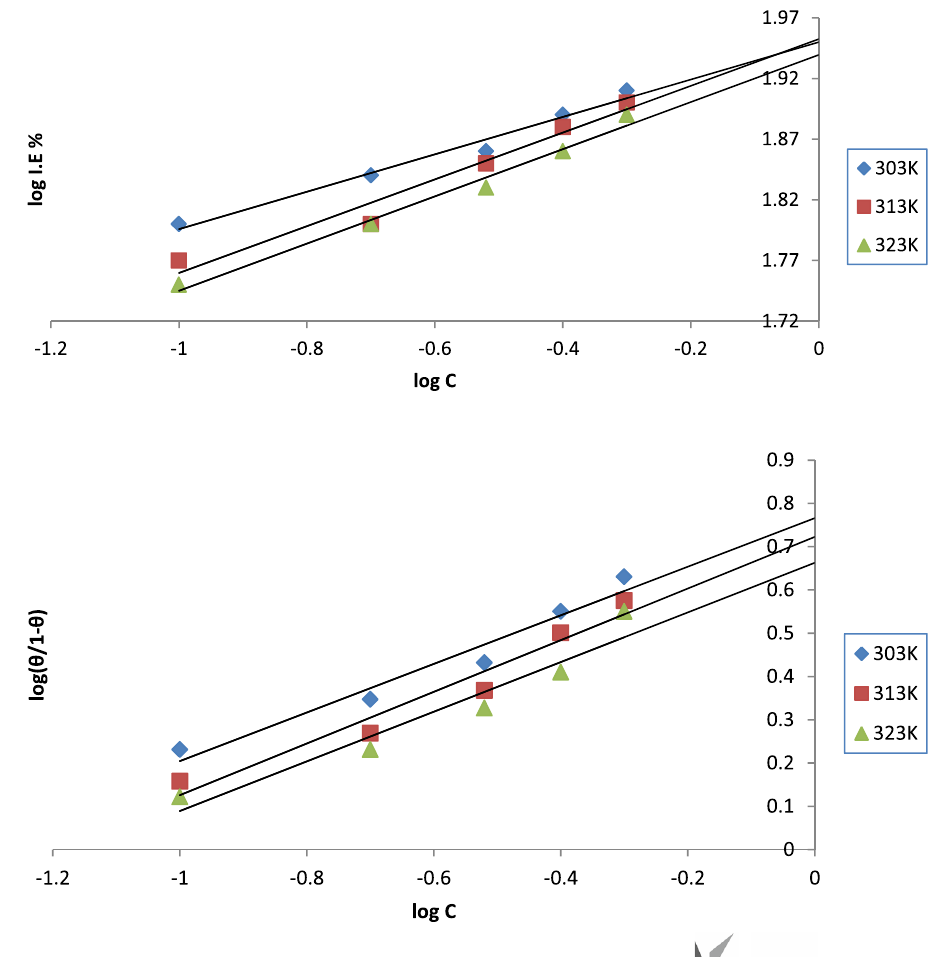
Fig. 4 Adsorption of Freundlich isotherm plot of Gongronema latifolium on the surface of mild steel at different temperatures